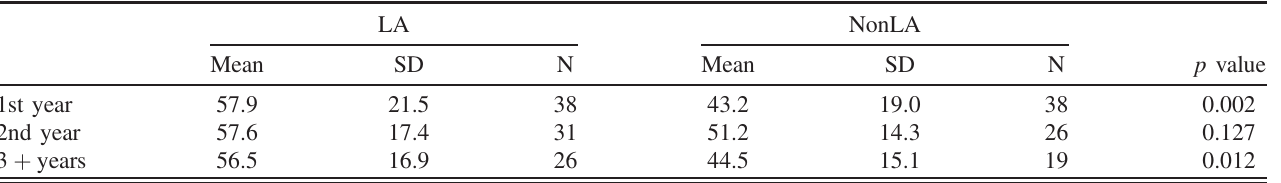
TABLE VI. Overall RTOP scores for LAs and nonLAs organized by years of